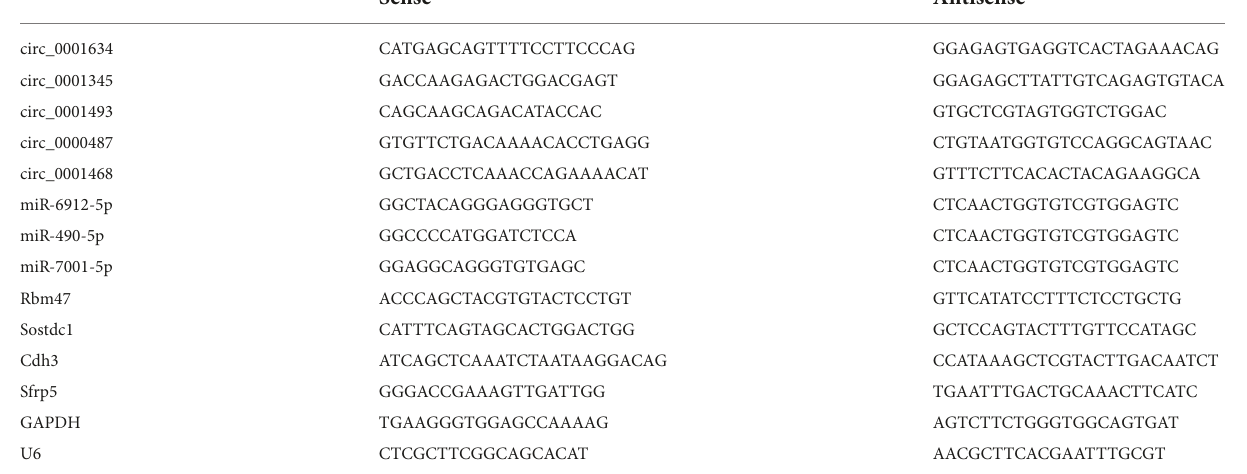
TABLE 2 The primer sequences used for